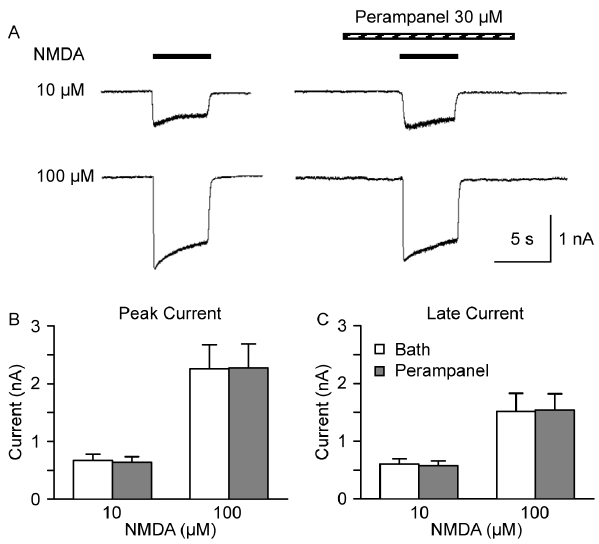
Figure 5. Perampanel does not inhibit NMDA-evoked currents in cultured hippocampal neurons. (A) Sample currents evoked by 10 and 100 m M NMDA in the absence ( left panels ) and presence ( right panels ) of perampanel (30 m M). (B) Mean 6 S.E.M. peak amplitude of currents evoked by 10 and 100 m M NMDA during control conditions (bath perfusion) and in the presence of perampanel. (C) Mean 6 S.E.M. late amplitude of currents evoked by 10 and 100 m M NMDA during control conditions (bath perfusion) and in the presence of perampanel. Each bar represents data from 6 neurons.